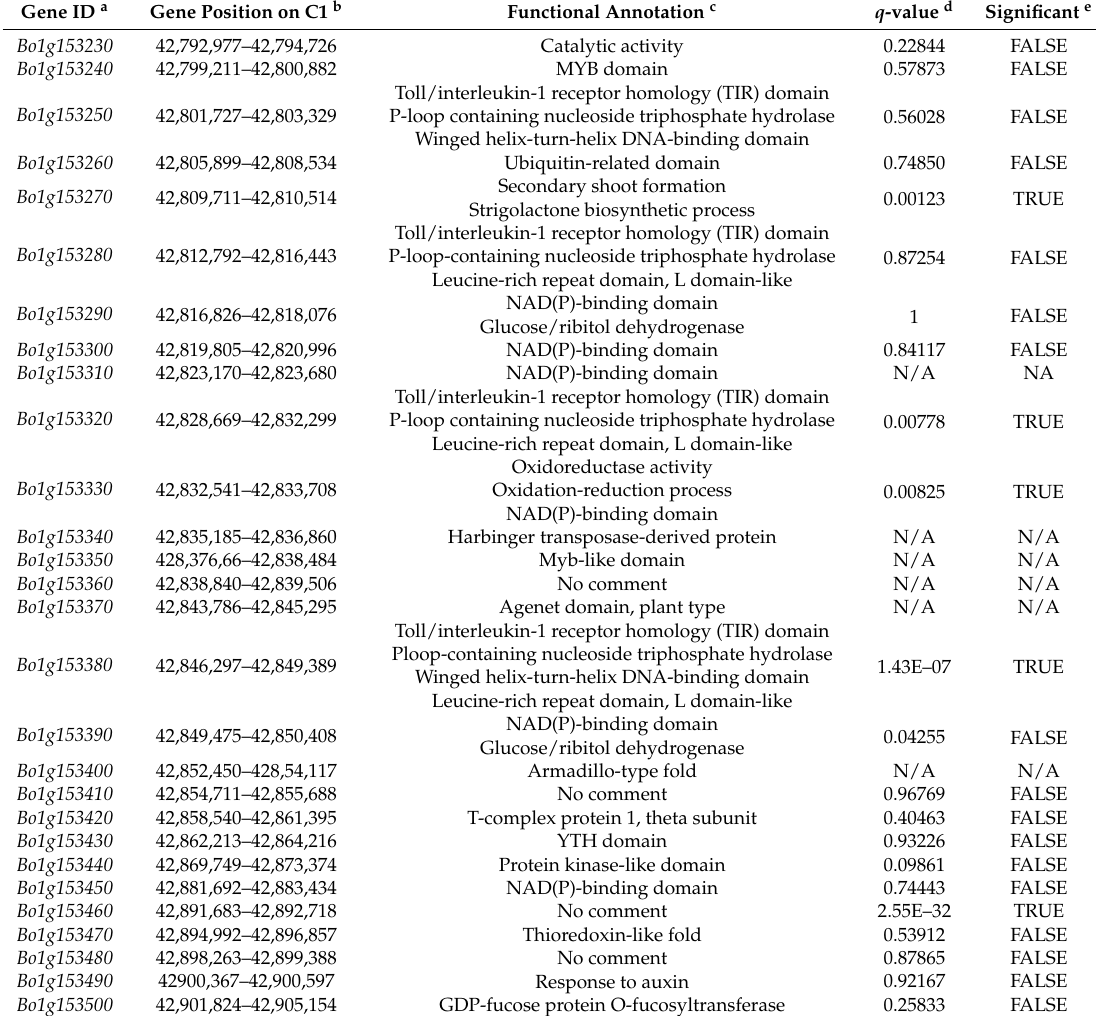
Table 1. Annotations and changes in gene expression in the mapping region of BoHL1